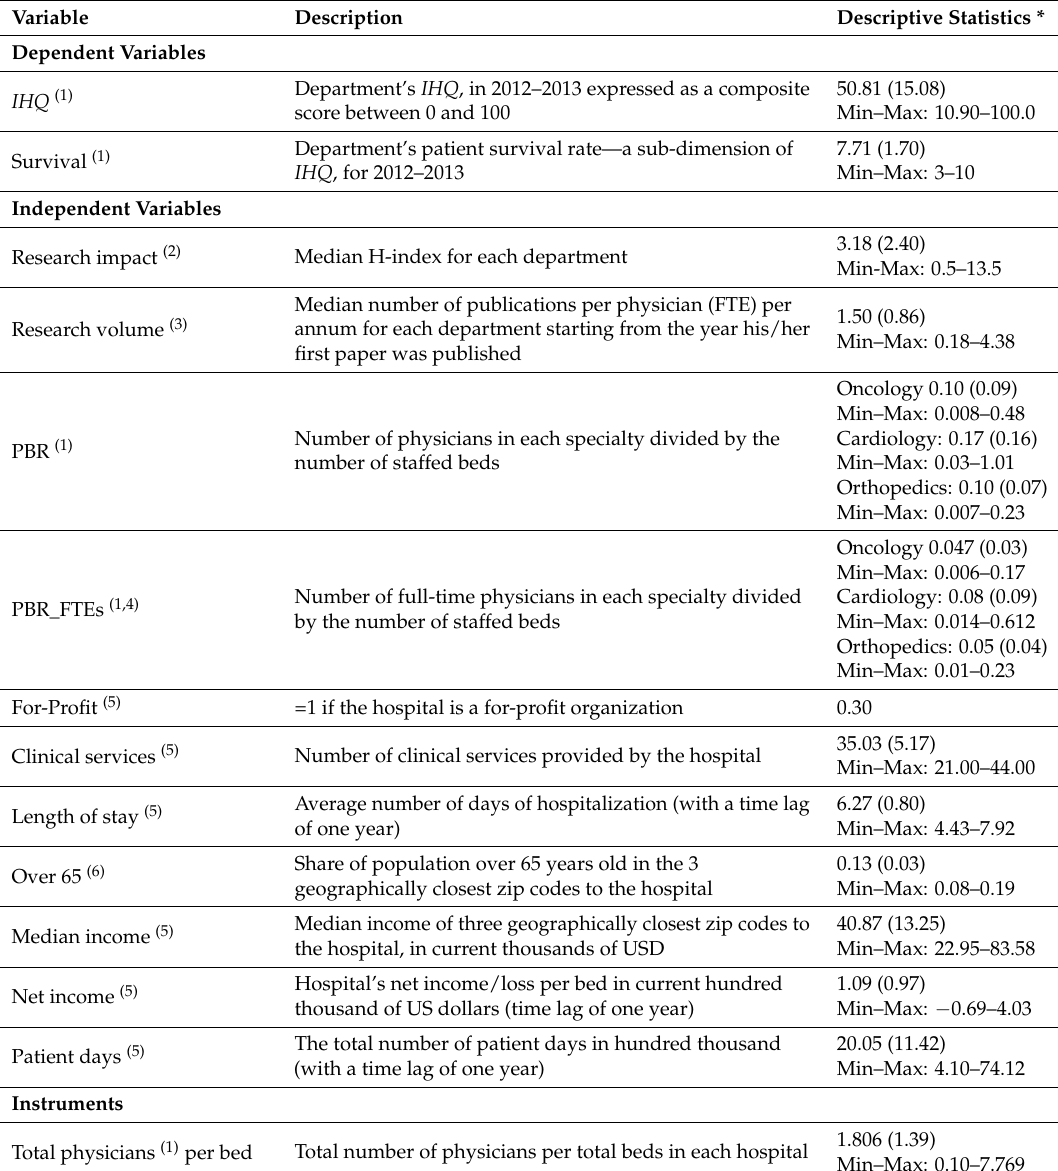
Table 1. Descriptive statistics of variables employed in the regression